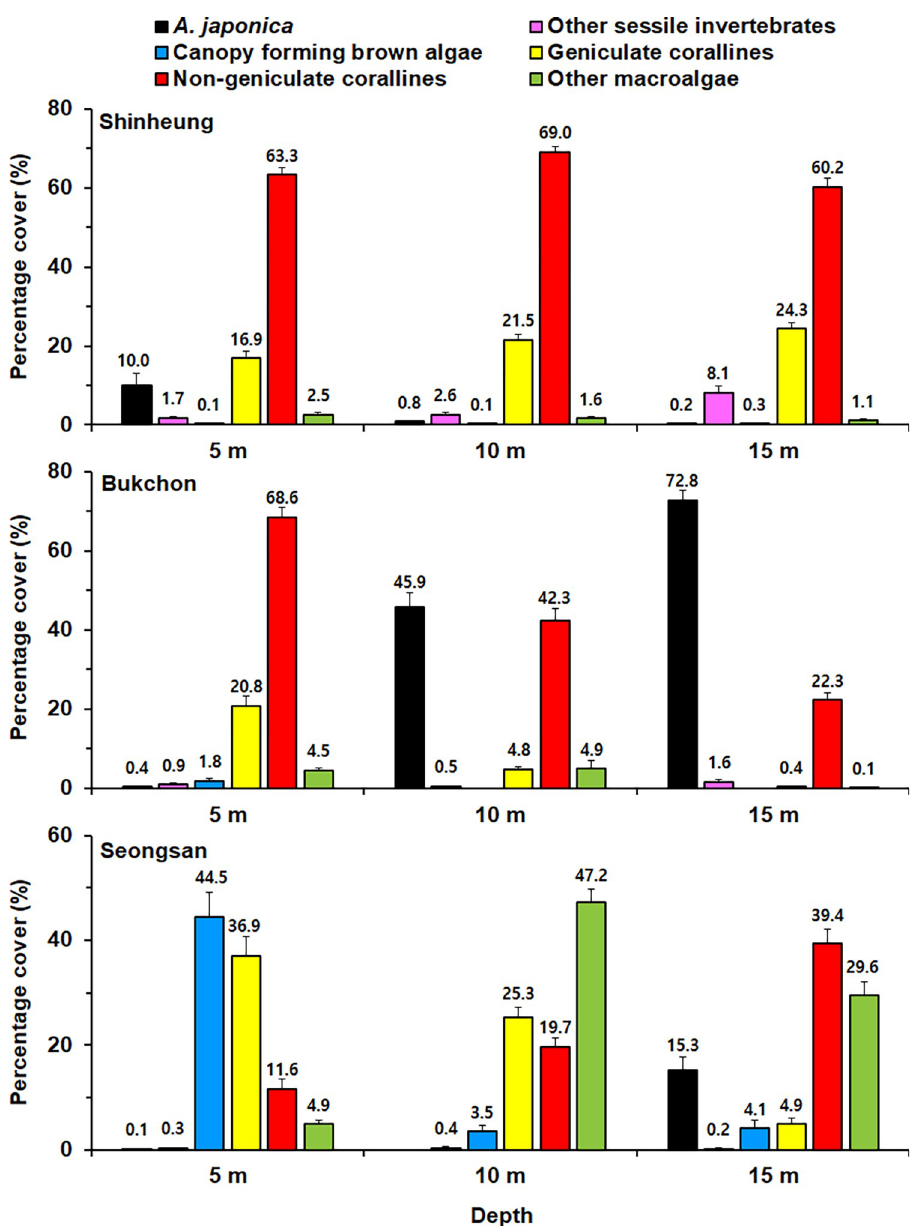
Fig 5. Average percent cover of benthic community estimated on 20-m line transects installed at depths of 3 survey sites SH, BC, SS. The percent cover is followed by the standard error.